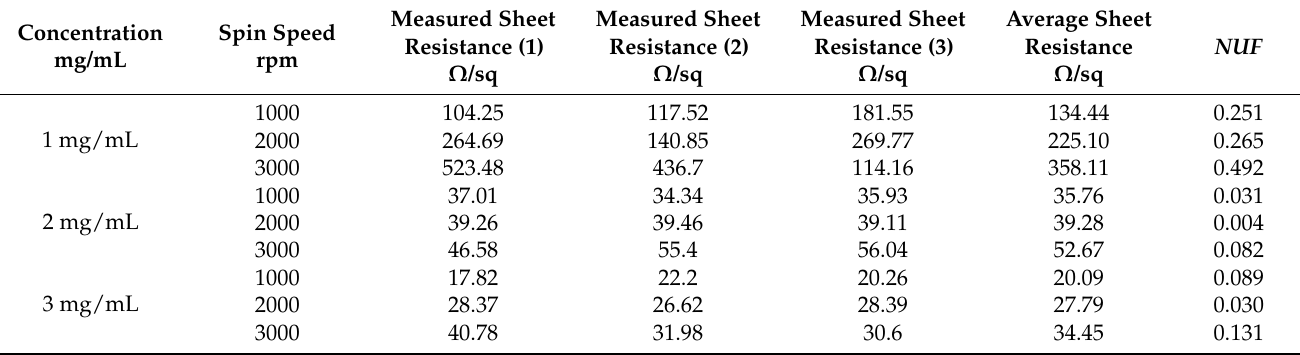
Table 2. Measured sheet resistance, average sheet resistance, and the nonuniformity factor ( NUF ) of AgNW transparent electrode at different concentrations and spin